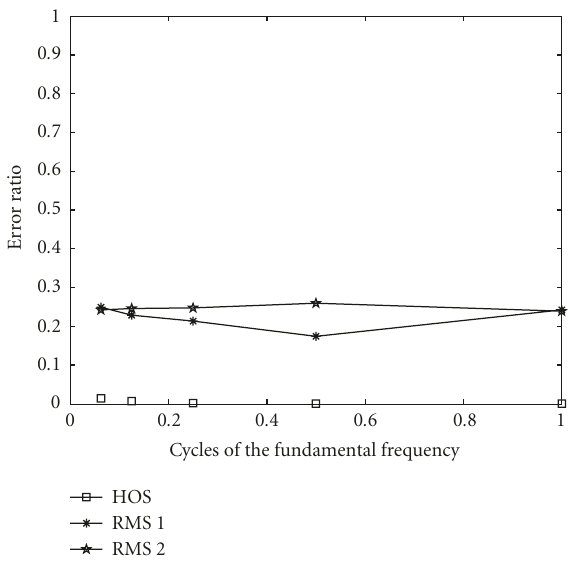
Figure 10: Error detection rate when the frame length is equal to one cycle of the fundamental component and the SNR ranges from 5 up to